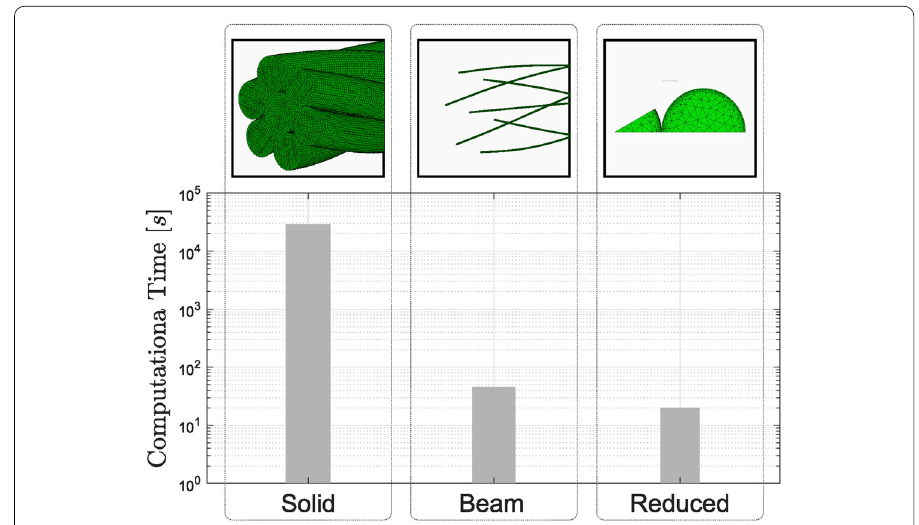
Fig. 4 Solid continuum elements (left), beam elements (center) and reduced elements (right), with corresponding computational times for the simulations shown in Fig. 3